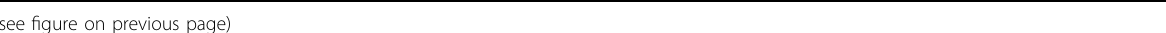
Fig. 4 CAP regulated the M1 and M2 activation states. a – j SN tissue sections, adjacent to those used to produce Figs. 1 and 2, were immunostained with various antibodies. a The number of CD11b + cells in the SN at the indicated time points. b – j SN sections were immunostained simultaneously with antibodies against CD11b and iNOS ( b – d ; 1 day), CD11b and arginase 1 ( e – g 1 day), or CD11b and CD206 ( h – j ; 7 days). Each image was captured from the same area and merged (yellow). Scale bar: 25 μ m. k Percentage of CD11b + cells in the SN with iNOS + , arginase 1 + , or CD206 + signal at the indicated time points. l – n Western blot analysis showing iNOS, COX-2, or arginase 1 expression in the LPS-treated SN, with or without CAP (1 mg/kg, i.p.). Intact or PBS-treated SN samples were used as controls. Optical density of bands for iNOS ( l , 1 day), COX-2 ( m , 1 day), or arginase 1 ( n , at the indicated time points) were measured and quanti fi ed. The data are presented as the means±SEM of 4 – 5 animals per group. * p < 0.05, *** p < 0.001 compared with PBS-injected SN treated with vehicle at the same time point; # p < 0.05, ## p < 0.01 compared with LPS-injected SN treated with vehicle at the same time point; ∞ p < 0.01 compared with LPS-injected SN treated with CAP at the same time point; + p < 0.001 compared with LPS-injected SN treated with vehicle at 1 d; & p < 0.01, compared with LPS-injected SN treated with vehicle at 3 days; % p < 0.05, %% p < 0.01 compared with PBS-injected SN treated with vehicle (ANOVA and Bonferroni